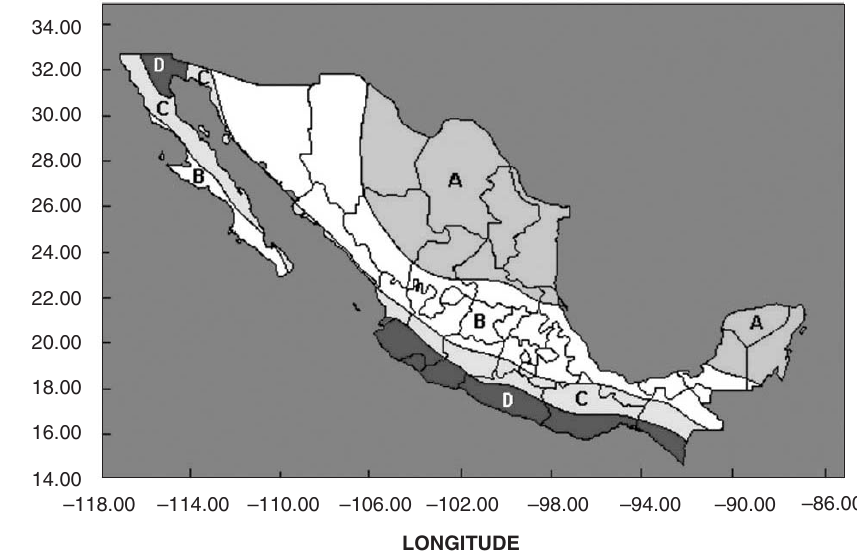
Fig. 4. Mexican seismic zones: A = no historical earthquake records for the last 80 years; B and C = interme- diate zones; D = large historical earthquakes recorded (courtesy of Servicio Sismologico Nacional, Instituto de Geofisica, UNAM,